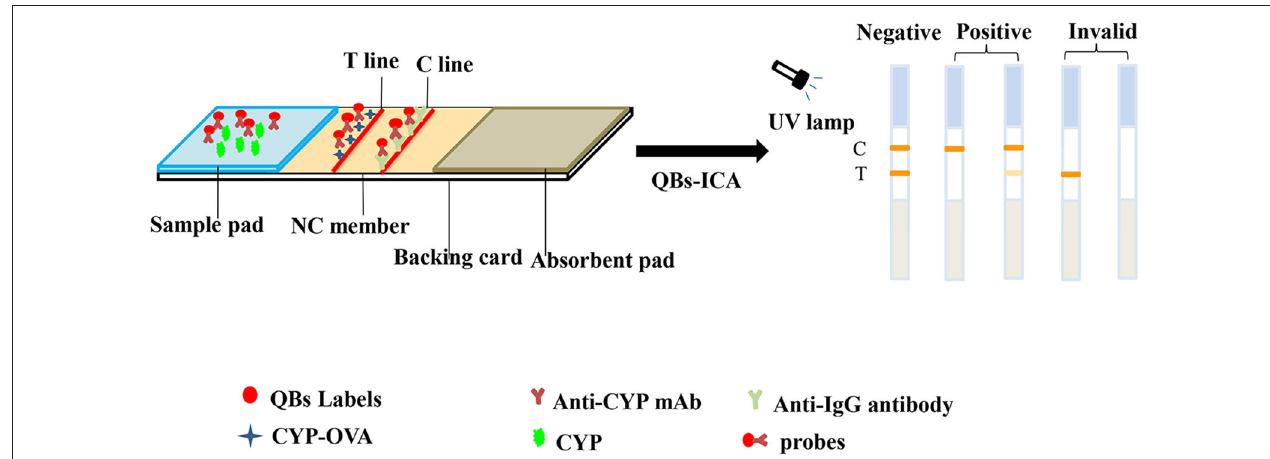
FIGURE 2 | Schematic diagram of QBs-ICA